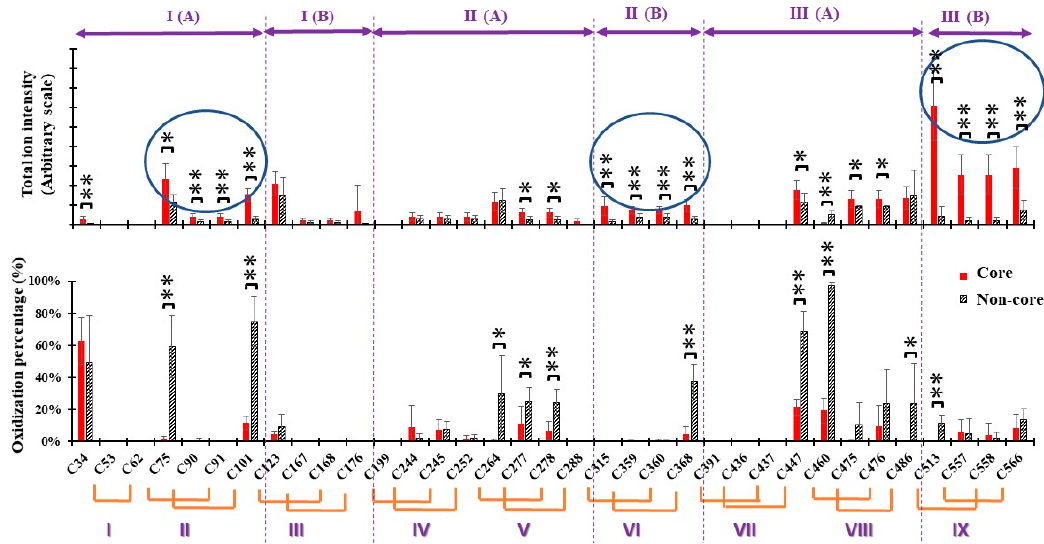
Figure 5. ( a ) Ion intensity and ( b ) oxidization percentage of cysteine-containing peptides covering individual cysteine sites detected from the core (red) and non-core (gray) fraction. Each data point was the average of 5–6 independent measurements with ± 1 standard deviation (error bar). Differences